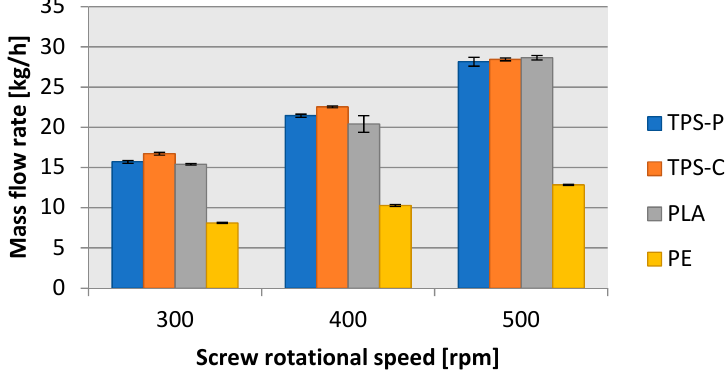
Figure 15. Dependence of the mass flow rate of the film measuring section on the rotational speed of the extruder screw.